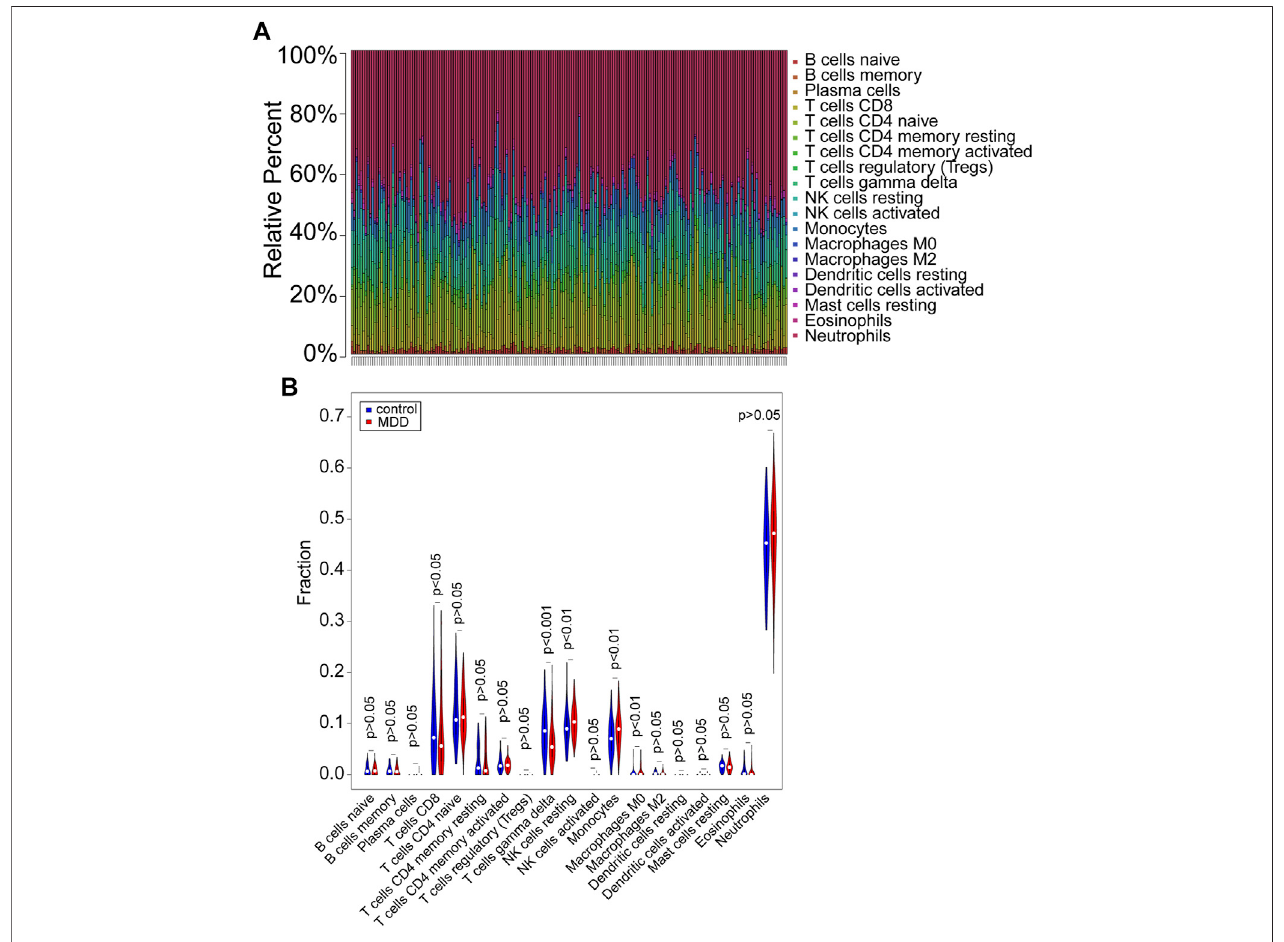
FIGURE 1 | Evaluation and visualization of immune cell in fi ltration in the GSE98793 dataset. (A) The proportion of immune cells in the MDD and control groups. Immune cells were represented by different colors. The vertical bars represented different samples. (B) The violin plot exhibited the differences in CIBERSOFT immune cell fractions between MDD and controls. MDD ( n = 128): major depressive disorder. Control ( n = 64): healthy donors. CIBERSOFT: an analytical tool from the Alizadeh Lab andNewmanLab toimpute geneexpression pro fi lesandprovideanestimationoftheabundancesofmember celltypesinamixedcellpopulation,usinggene expression data. p < 0.05 was considered statistically signi fi